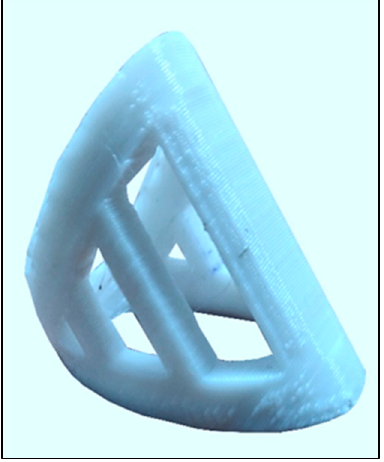
Figure 10. 3D printed splint. A total of 185 splints were prescribed to the subjects for an intervention period of four weeks. The most common joint involved was the proximal interphalangeal joints in most of the patients. A brief description of the subject demographics and splints is de- scribed in Table 1. The post-splinting period constantly had followed-up services through phone calls and emails, and modifications were done if needed. The subjects were con- stantly monitored for splint use and its effects on their deformities. The measures used to evaluate the performance of these splints were performed after four weeks. The results estimated are discussed below in the further subsections. Table 1. Subject demographics and splint details Subject